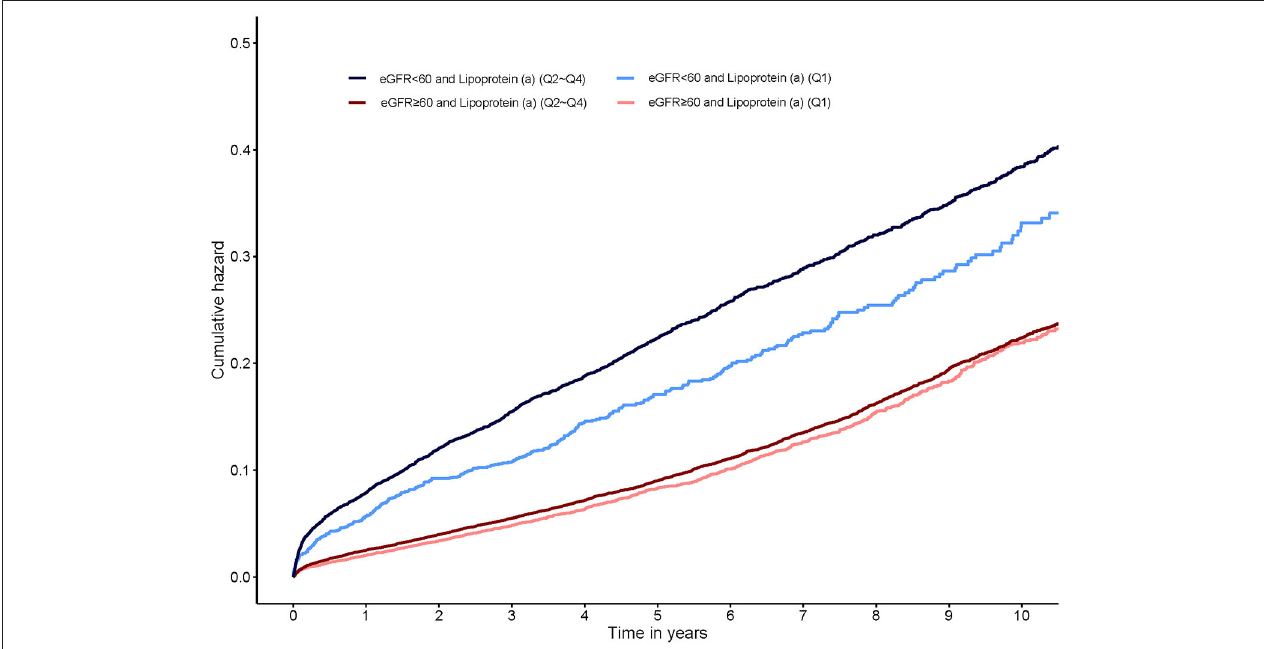
FIGURE 2 | Kaplan-Meier curves for cumulative hazard of all-cause mortality by lipoprotein(a) categories stratified eGFR.